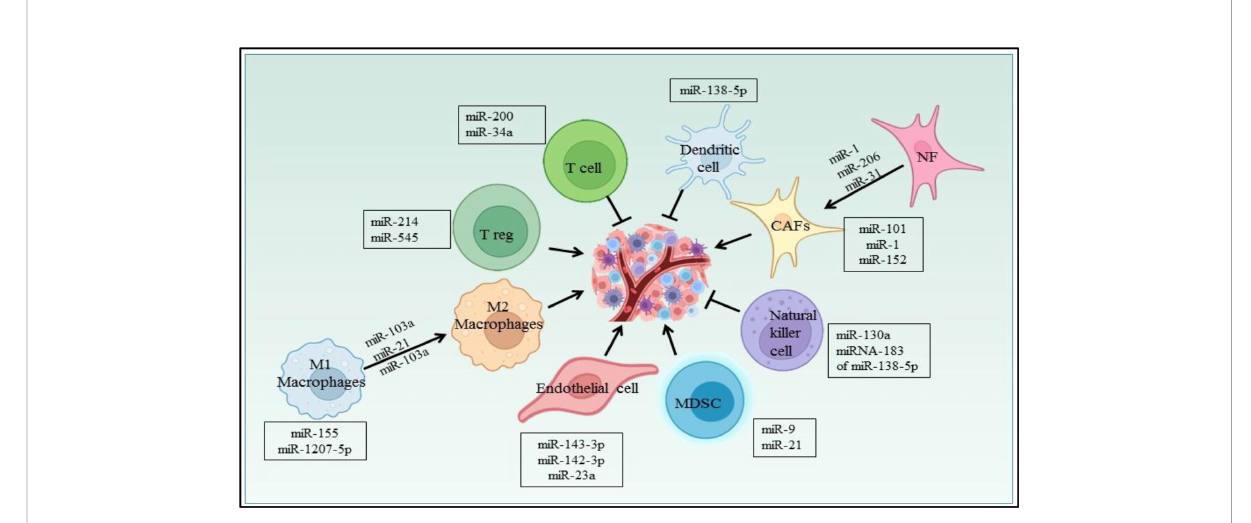
FIGURE 6 miRNA regulating different cells in the NSCLC